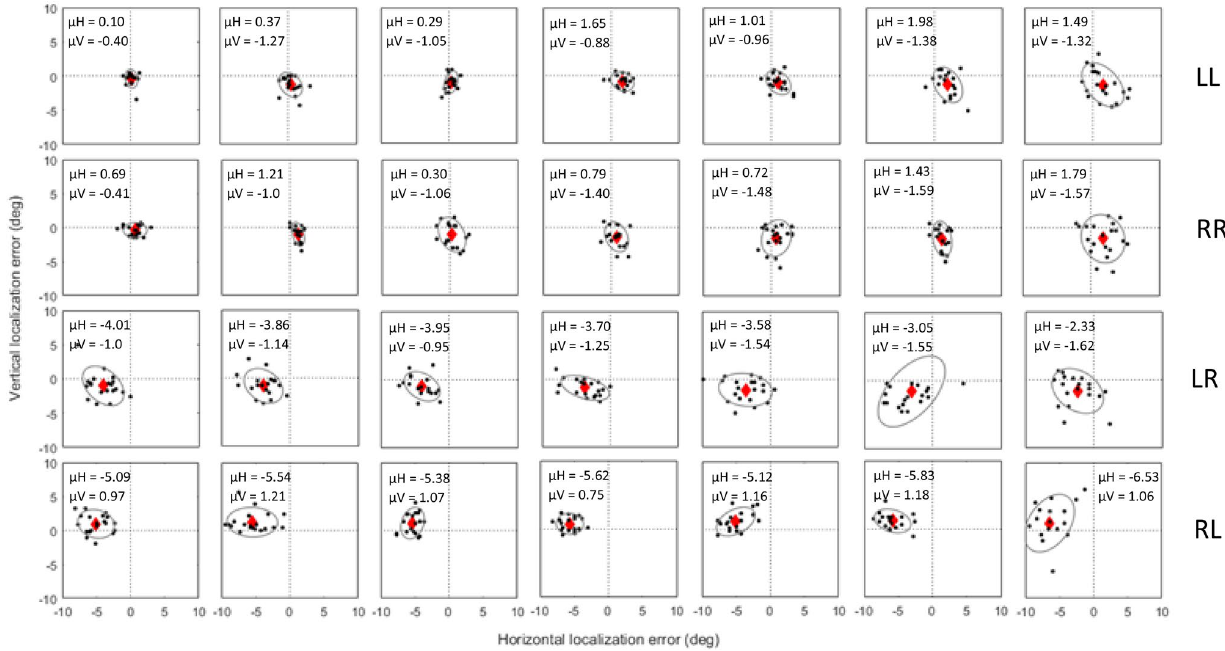
Figure 5. Scatter plot displaying horizontal and vertical localization error across inter-stimulus interval (0.25, 0.5, 1, 1.5, 2, 5, and 7 s left to right) under dichoptic viewing conditions in one subject (S8). LL, RR, LR and RL indicate which eye viewed the target disk and response disk. The bottom two rows show conditions where the disks were seen by alternate eyes (LR and RL). Black dots represent the error in localization for each trial. Red diamond marks the mean horizontal and vertical error in localization across trials. BCEA is represented by the grey